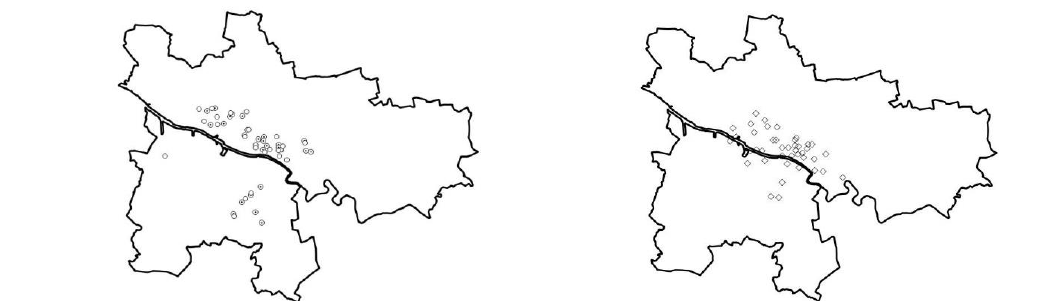
Figure 1. Calculation Process for matching of census data to service areas.